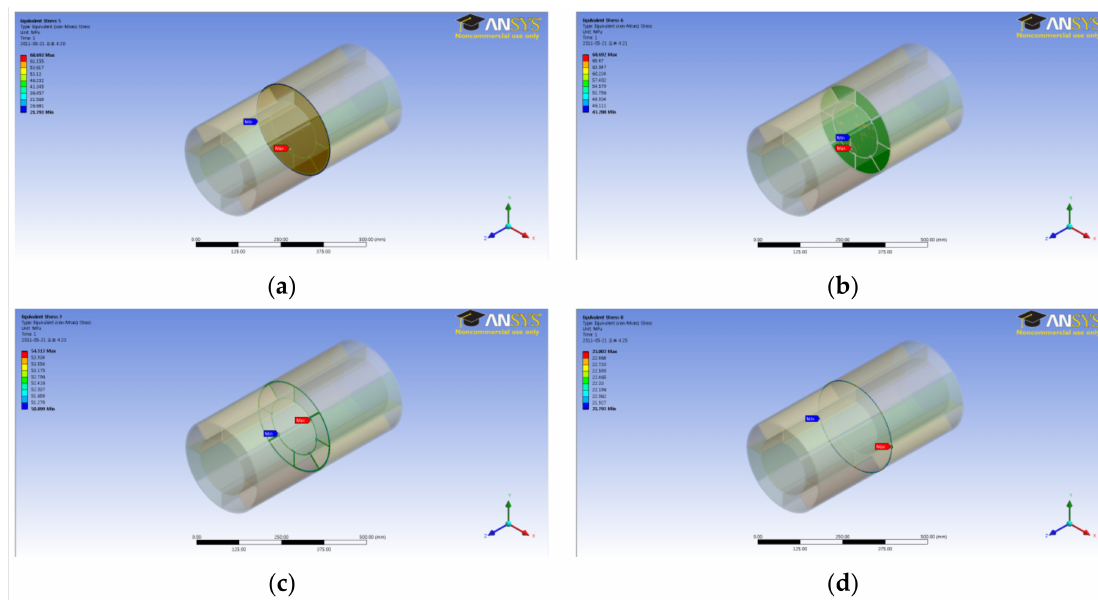
Figure 22. FEA of the center of the hybrid − CFFT: ( a ) overall, ( b ) concrete, ( c ) PFRP, and ( d )